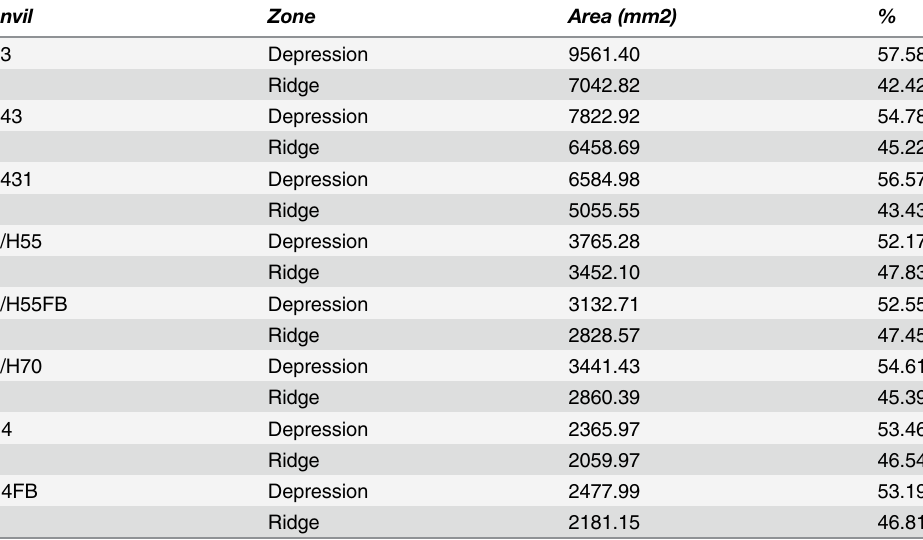
Table 2. Percentage of depressions and ridges in stone tool surfaces.